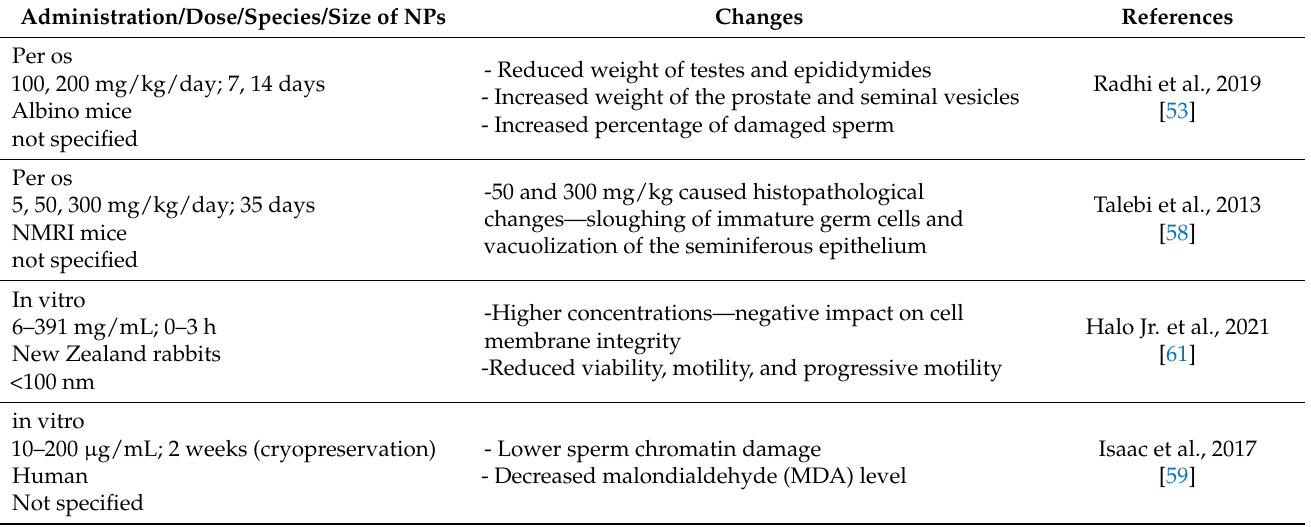
Table 3. Alterations in the male reproductive system caused by ZnO